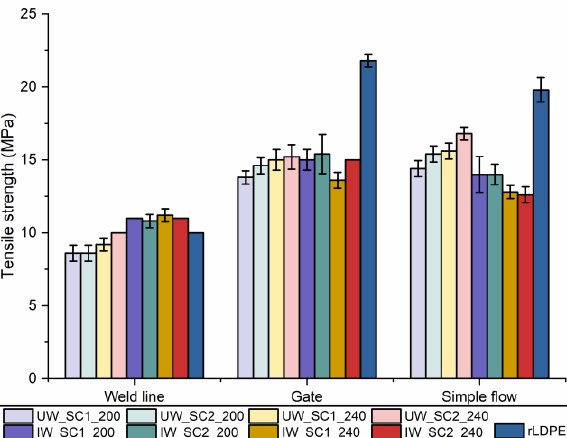
Figure 6. The tensile strengths of samples taken from different regions of the IM frame.